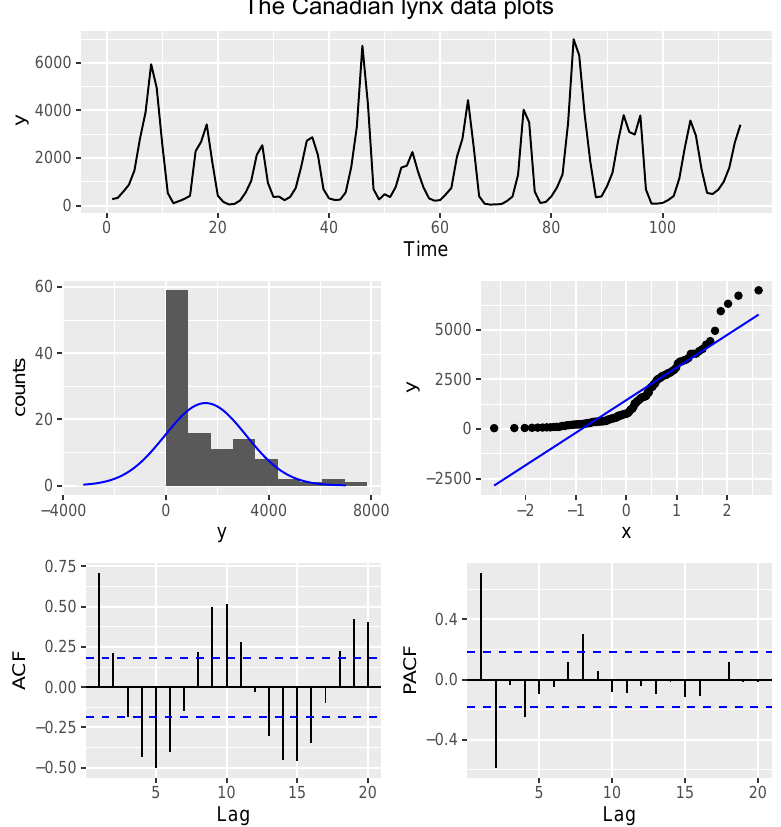
Figure 1. Diagnostic plots for the Canadian lynx data. The upper plot shows a time-series plot, which reveals evidence of stationarity. The middle plots are the histogram ( middle-left ) and the quantile–quantile plot ( middle-right ), and both plots suggest that the time series process has a non- normal distribution. The lower plots show the autocorrelation functions, and for both plots, the autocorrelations are close to zero, giving further evidence of